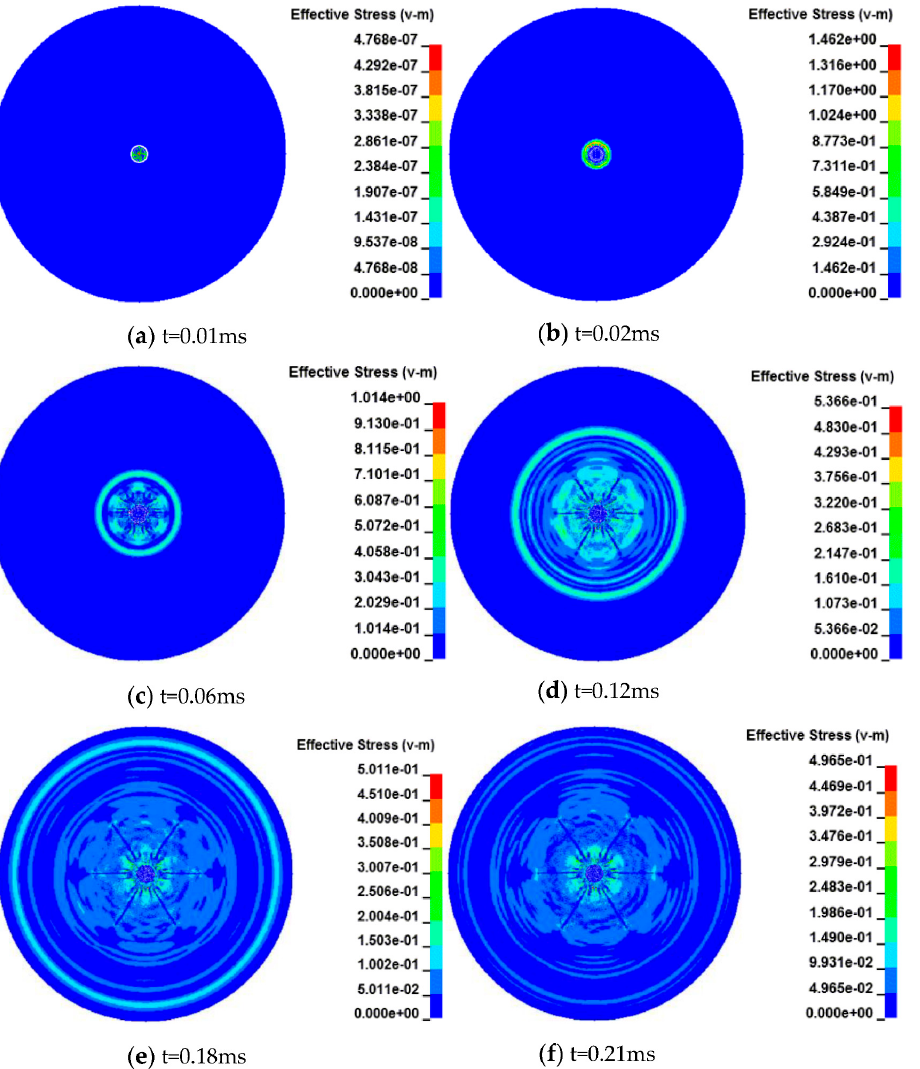
Figure 18. Stress evolution process of single-hole non-shaped charge blasting.